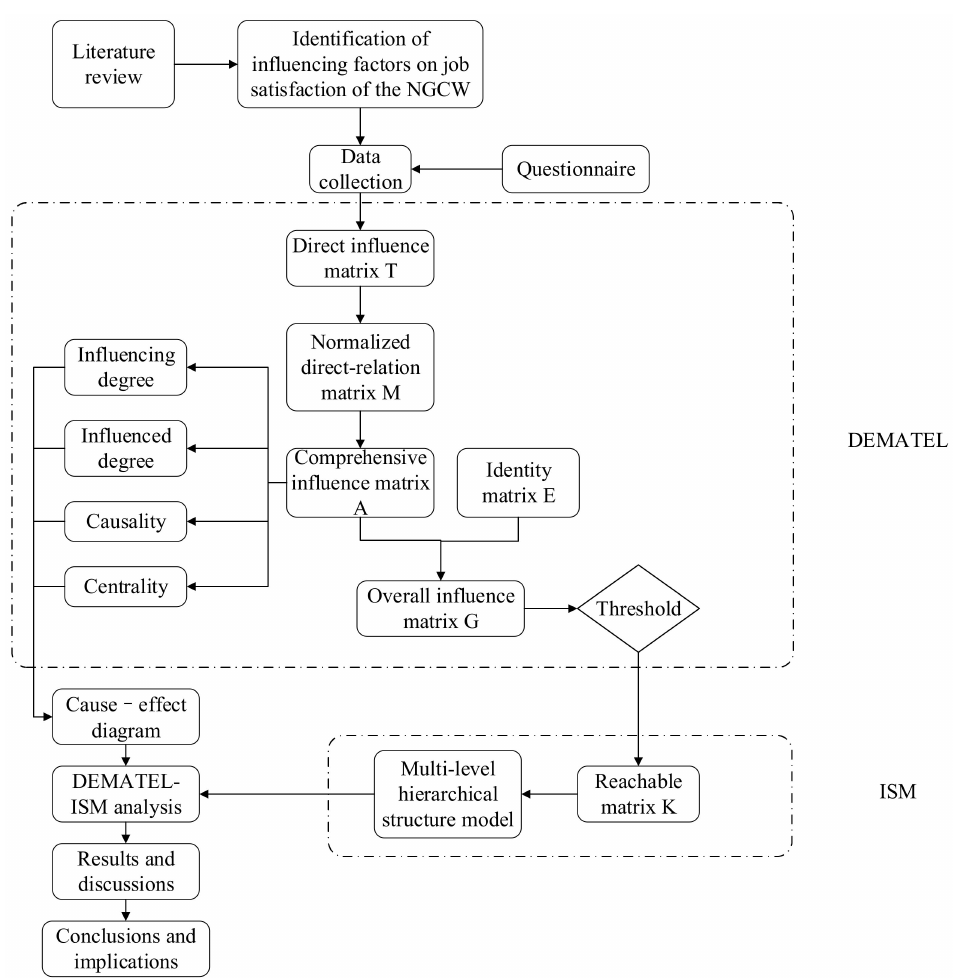
Figure 2. Framework for the integration of DEMATAL and